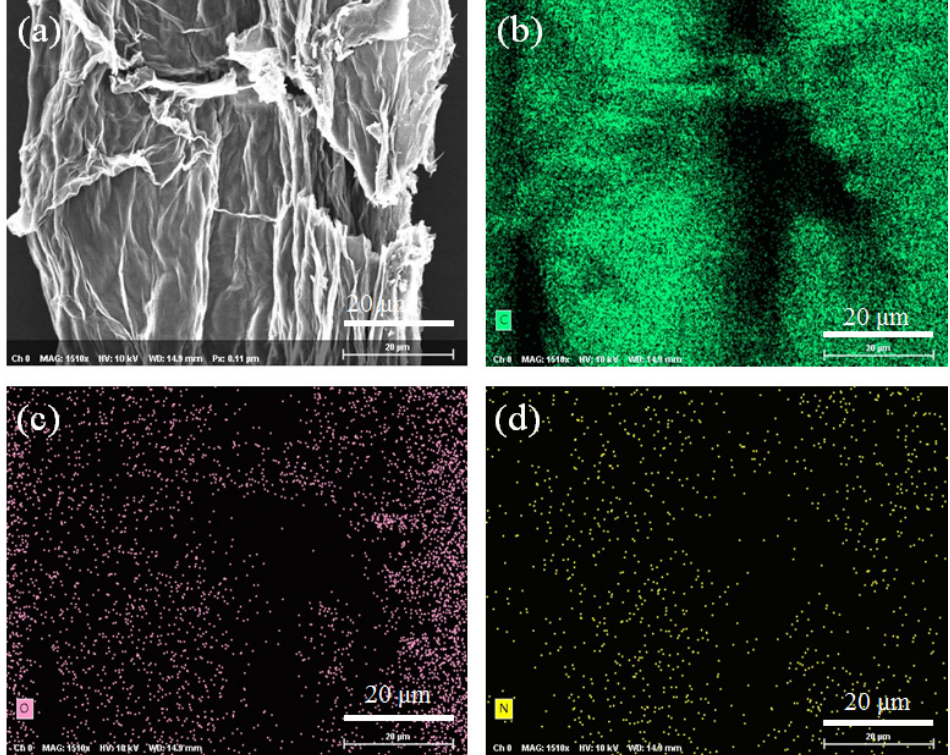
Figure 3. ( a ) EDX images of NSG@GF and ( b – d ) element distribution of carbon, oxygen, and nitrogen.